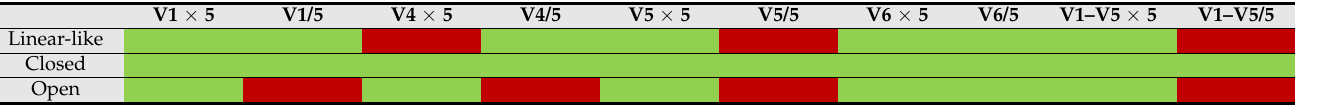
Table 2. Parameter variation consequences in the different models of Krebs’ cycle. Green indicates that, after perturbation, SS can be obtained. The red indicates that, after perturbation, SS cannot be obtained (no